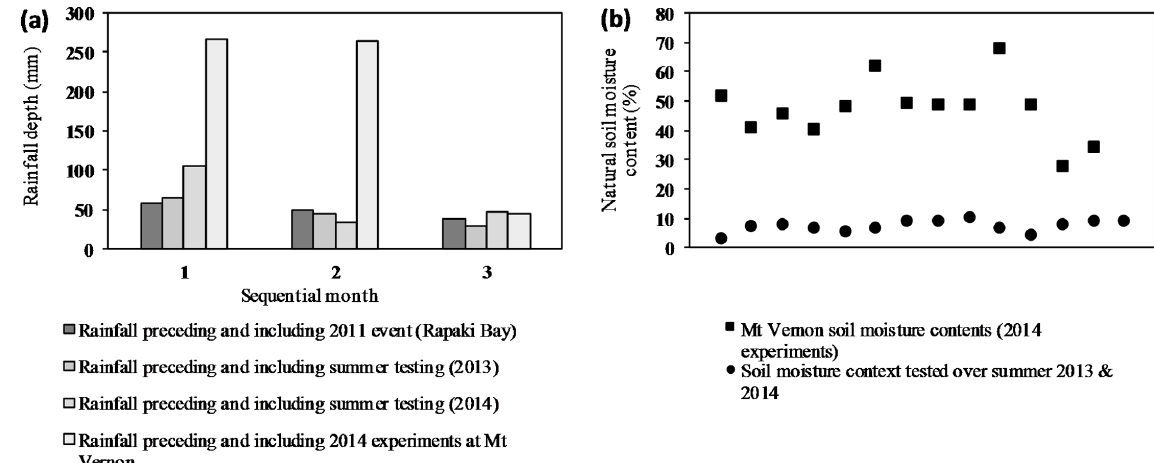
Figure 3. (a) Rainfall in the months preceding and during key events of this study: The 2011 earthquake rockfall event at Rapaki Bay, summer soil testing on the Port Hills in 2013 and 2014, and the rockfall experiments conducted at Mt Vernon in 2014. (b) Natural soil moisture contents as tested during the summer testing of 2013 and 2014 (Carey et al., 2014) and as tested during the Mt Vernon rockfall experiments.